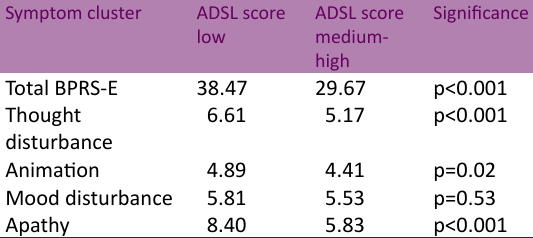
Table 5 BPRS scores and level of